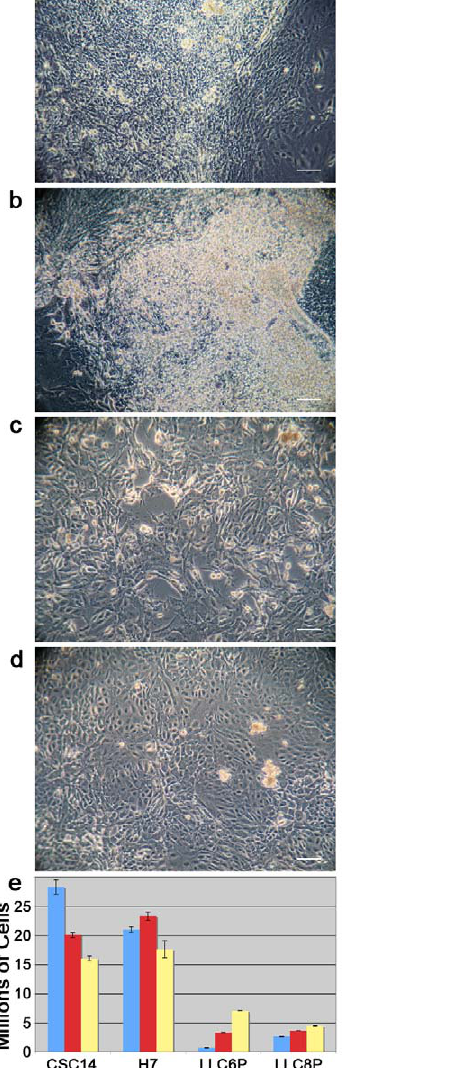
Figure 3. Exposure of hESC and phESC to a neural differenti- ation protocol yields quantitatively distinct cell populations. Conventionally-derived (a and b) and parthenote-derived (c and d) hESC have distinct growth patterns after the NPC differentiation protocol. Histograms plotting cellular yield (in millions of cells) after NPC differentiation (e) reveal that parthenote-derived lines yield fewer cells after differentiation than conventionally-derived lines. Scale bars represent 10 m m. Blue bars indicate differentiation 1, red bars indicate differentiation 2 and yellow bars indicate differentiation 3, representing the three successive